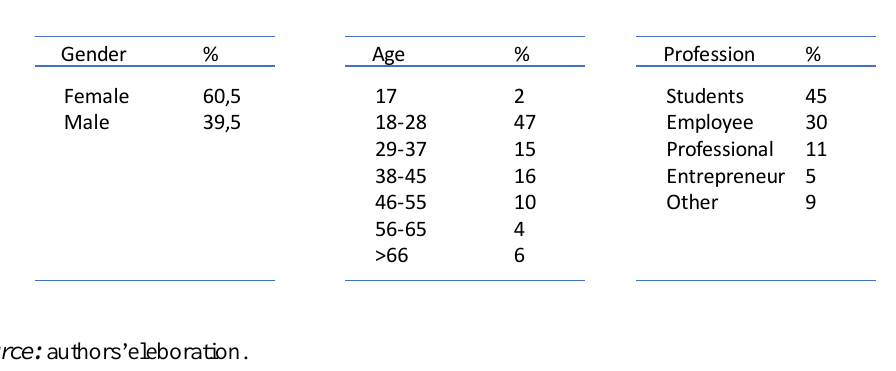
Table 2: Description of the Sample